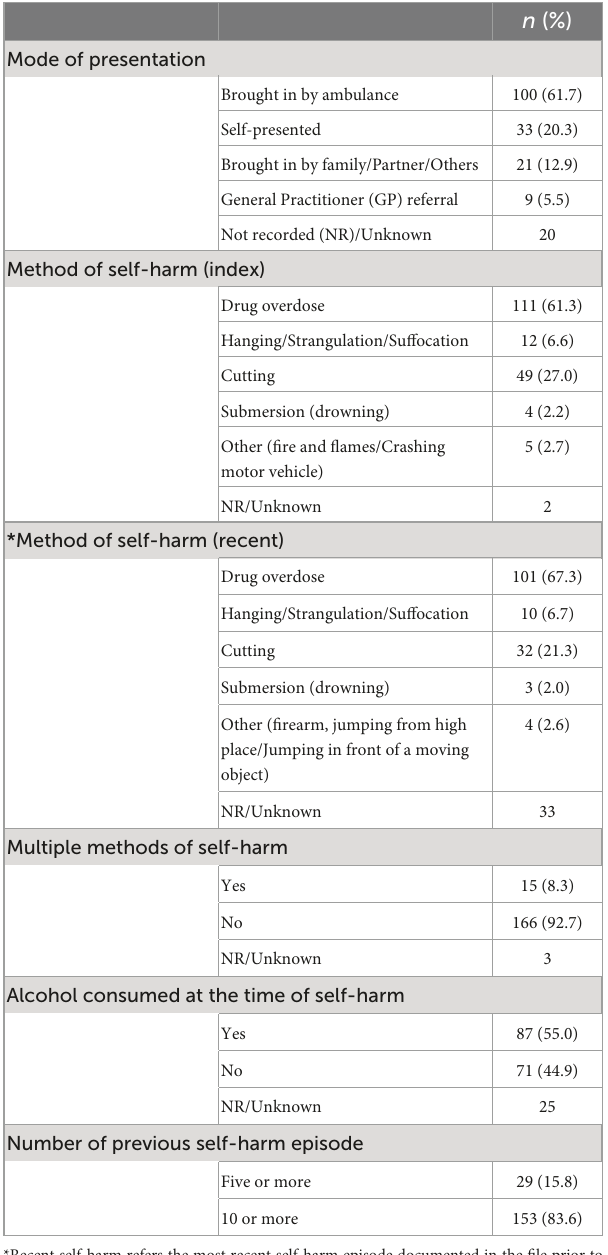
TABLE 2 Self-harm characteristics of the participants in file review study.